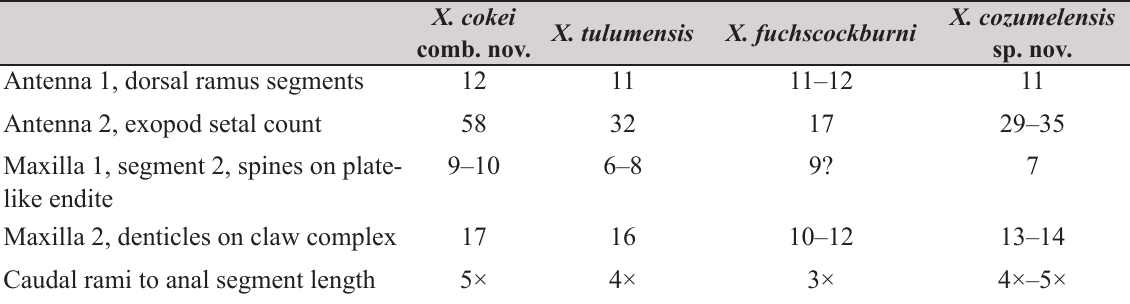
Table 3. Morphological comparisons among species of Xibalbanus from Yucatán, Belize, and Cozumel. Based on information presented here and from literature (Yager 1987, 2013; Neiber et al.